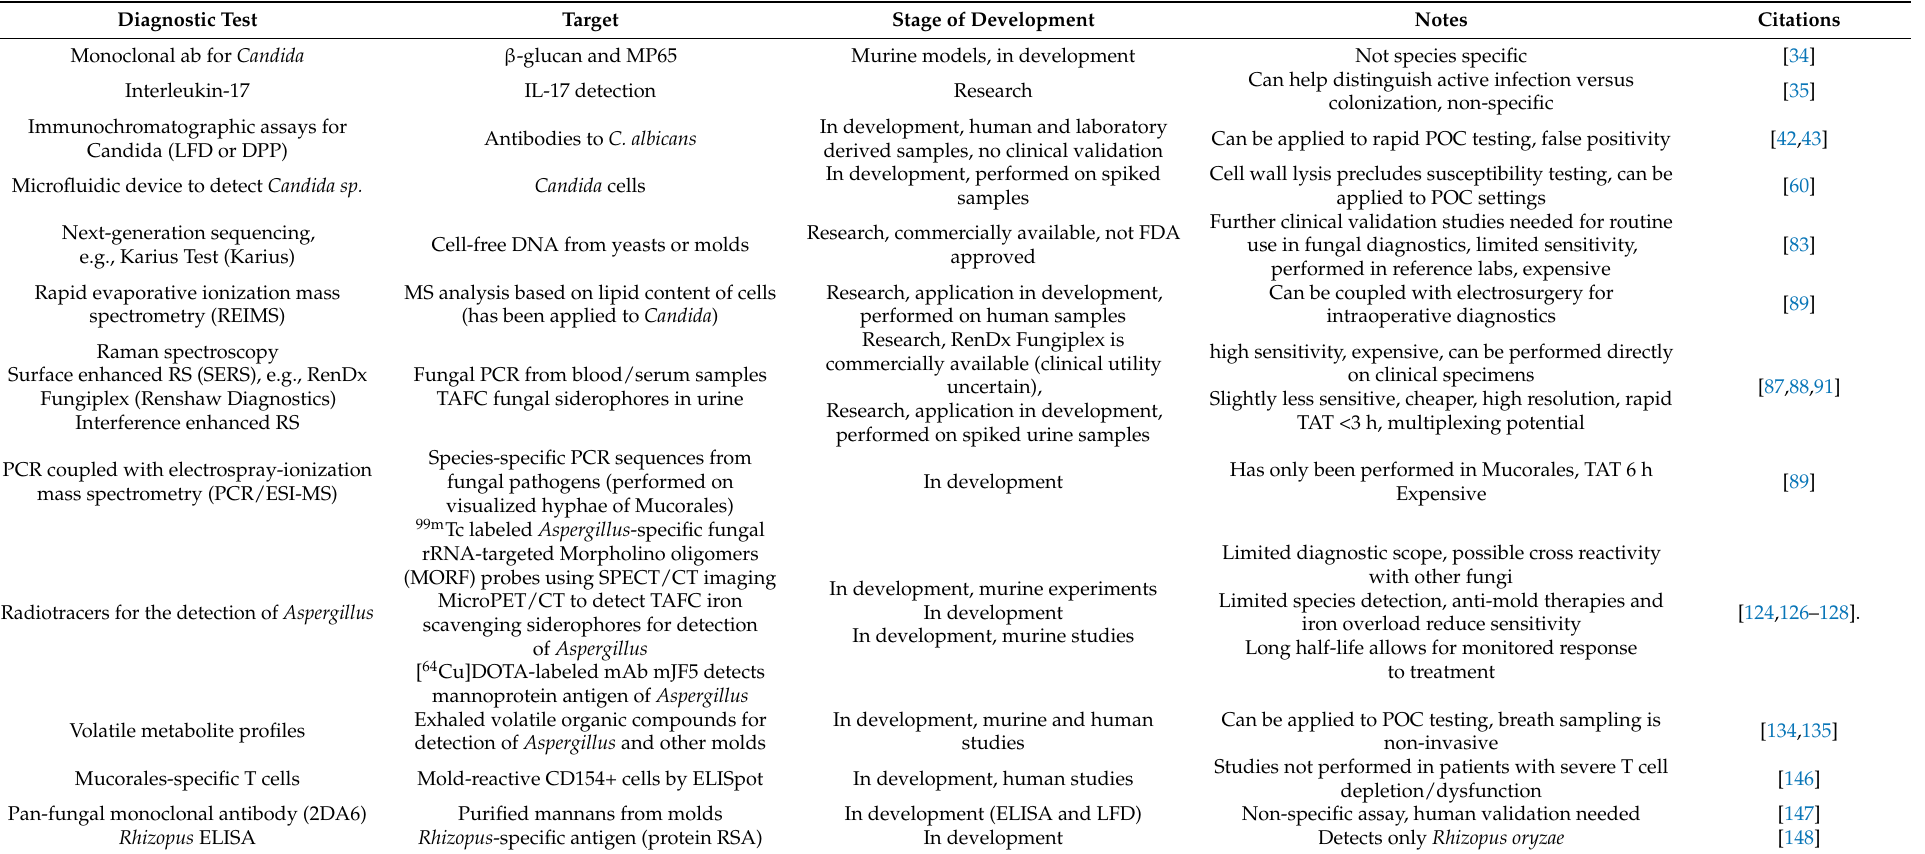
Table 3. Novel diagnostics for the detection of fungal infections. In development: the test is still undergoing preclinical or clinical validation and has been tested on a limited number of samples. Research only: can be performed in specialized laboratories but is not commercially available or FDA-approved